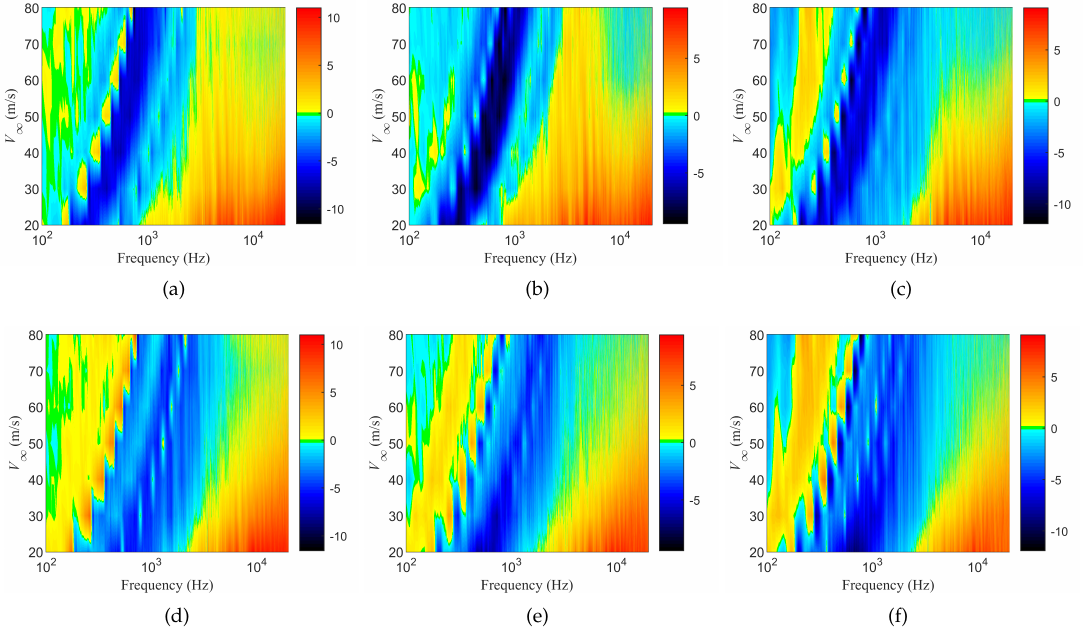
Figure 13. ∆ SPL as a function of frequency and flow velocity for different arrangements of the porous leading edges: ( a ) X80Y50Z20, L = 100 mm, α = 0 ◦ ; ( b ) X80Y50Z20, L = 200 mm, α = 0 ◦ ; ( c ) X80Y50Z20, L = 200 mm, α = 10 ◦ ; ( d ) X20Y50Z80, L = 100 mm, α = 0 ◦ ; ( e ) X20Y50Z80, L = 200 mm, α = 0 ◦ ; and ( f ) X20Y50Z80, L = 200 mm, α = 10 ◦